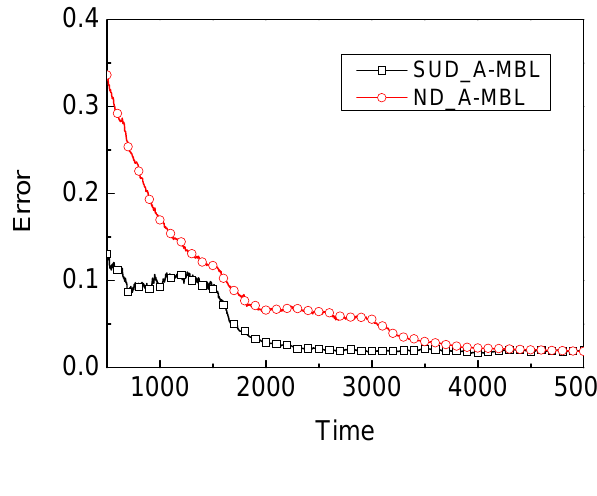
Figure 5. Accuracy comparison between SUD_A-MBL and